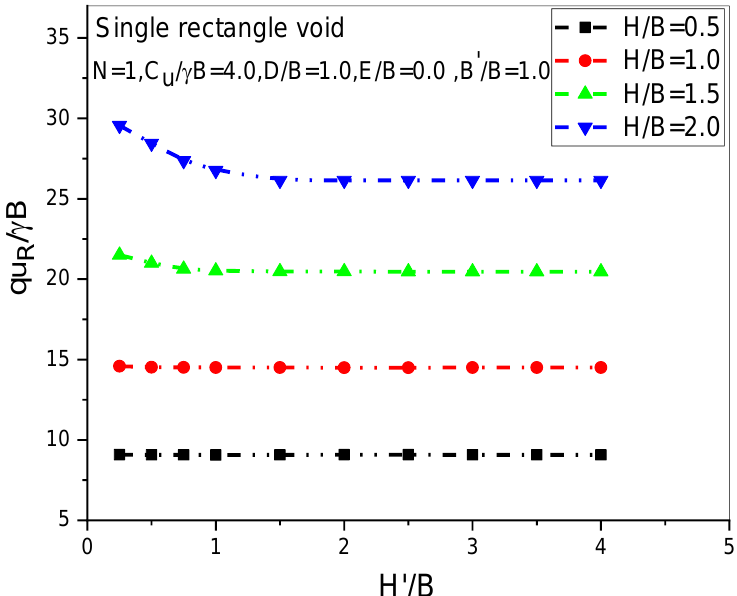
Figure 18. Effect of reinforcement on the ultimate bearing capacity ratio with a change in the void height.